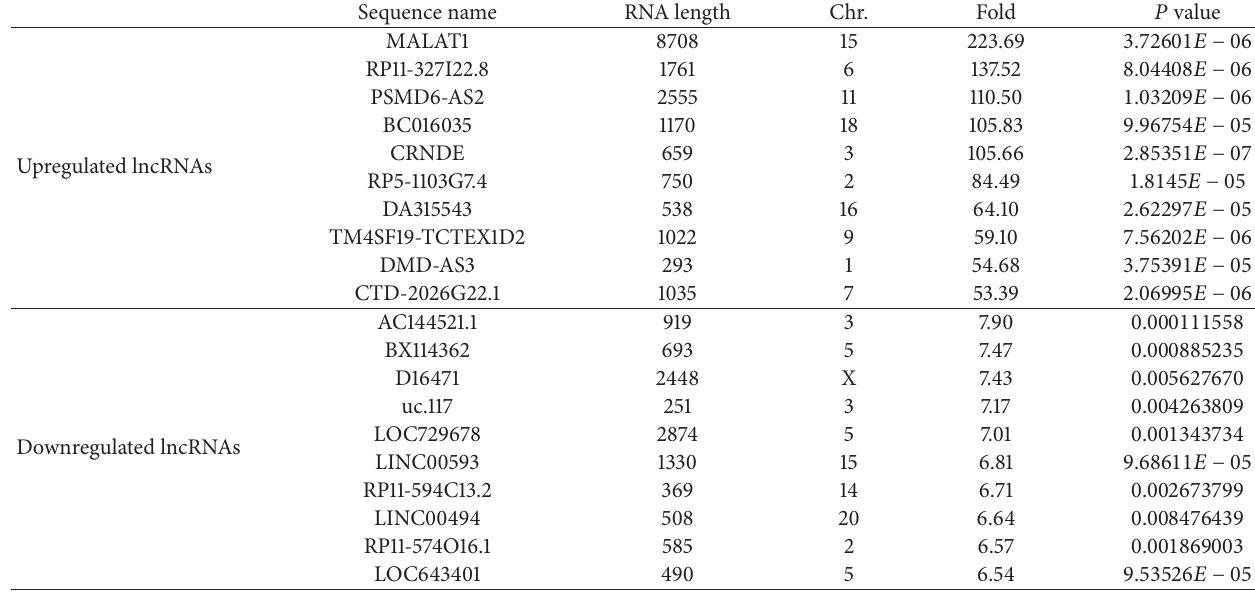
Table 1: 10 Most differentially expressed (up- and downregulated) lncRNAs in HUVECs upon TGF 𝛽 1 (10ng/mL) stimulation. Sequence name RNA